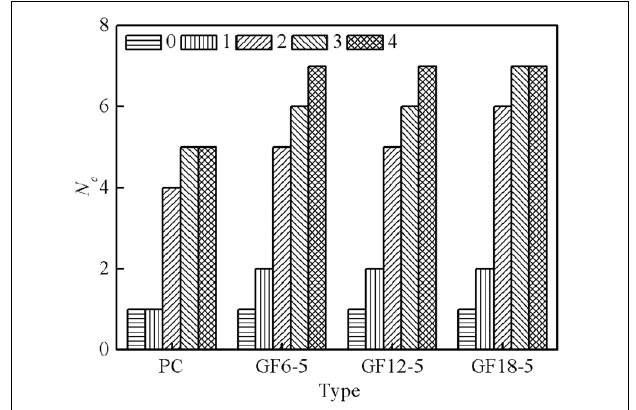
FIGURE 6 | Relationship between the number of cracks and short fiber length.